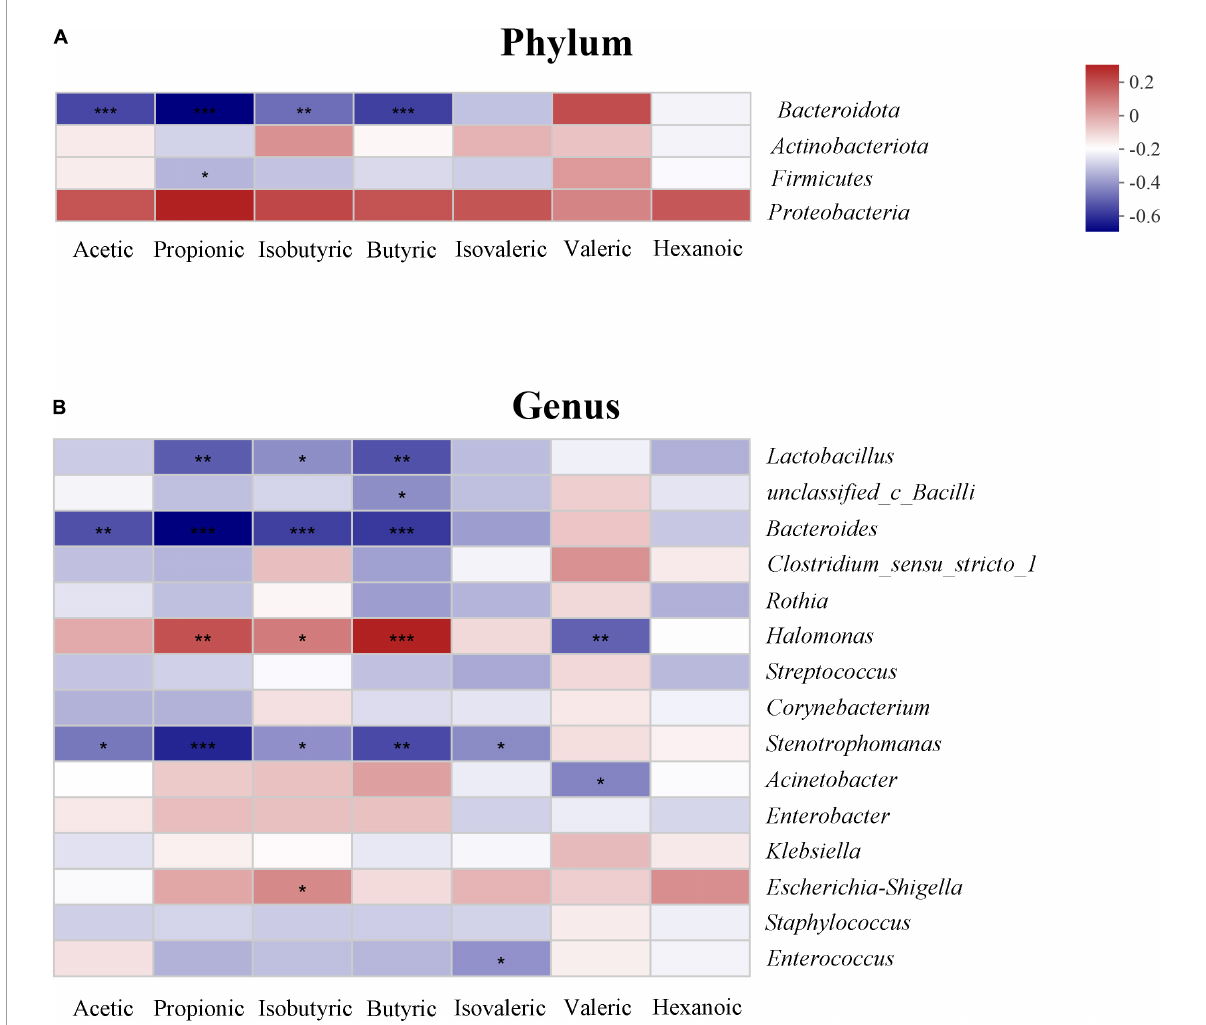
FIGURE6 Relationship between the gut microbiota and short-chain fatty acids (SCFAs) on phylum (A) and genus level (B) in the study. The change in color reflects the data in the two-dimensional matrix. The color depth indicates the size of the value, and it can intuitively express the size of the value in a defined color